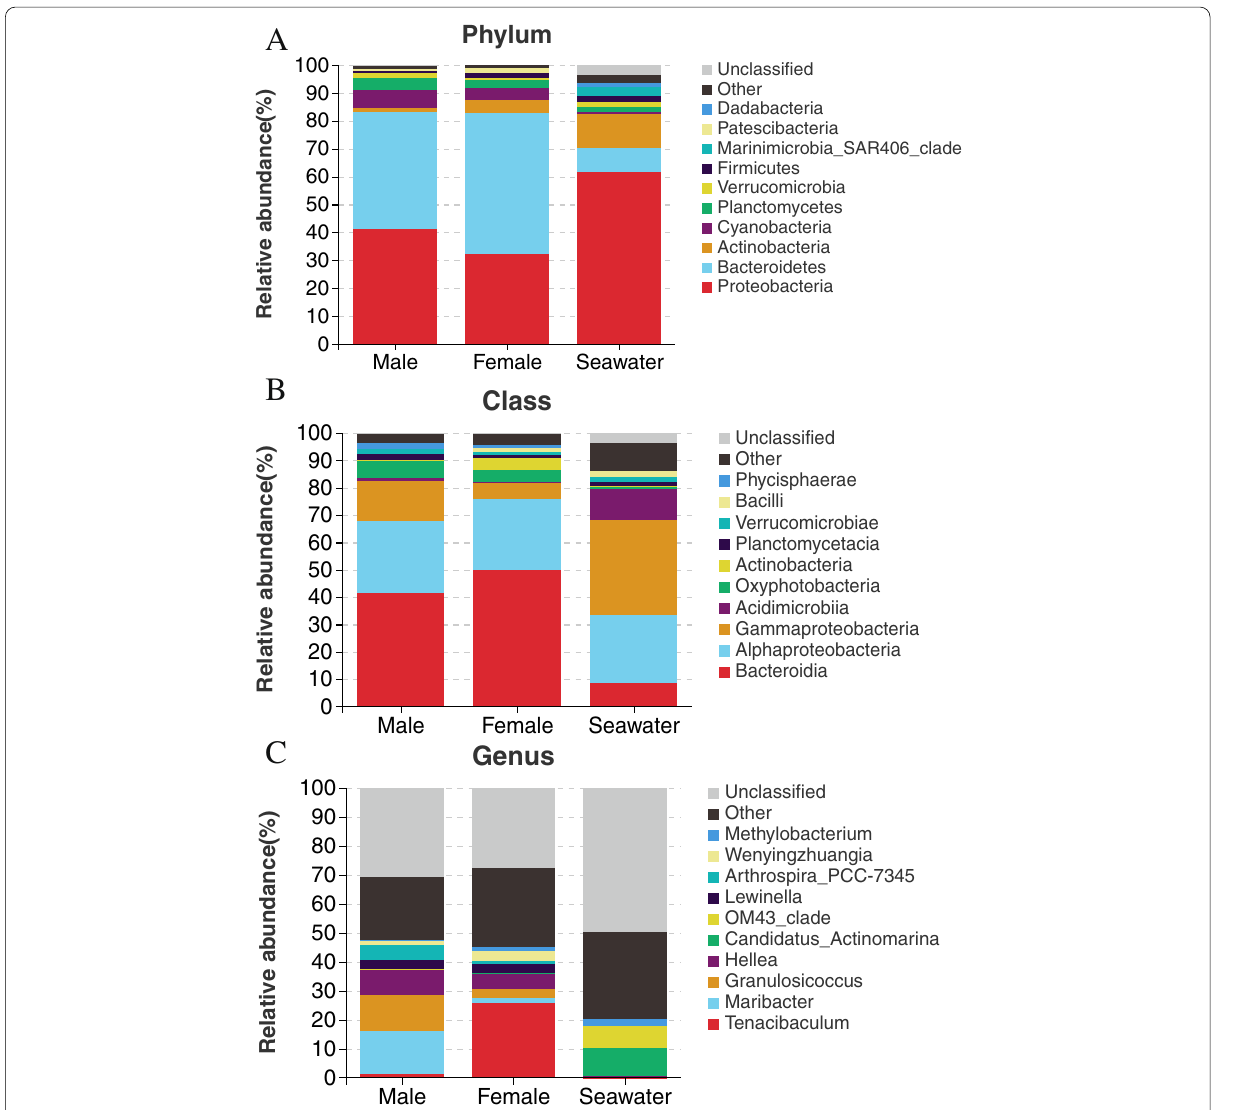
Fig. 4 A Phylum-level taxonomic composition of the bacterial community. B Class-level taxonomic composition of the bacterial community. C Genus-level taxonomic composition of the bacterial